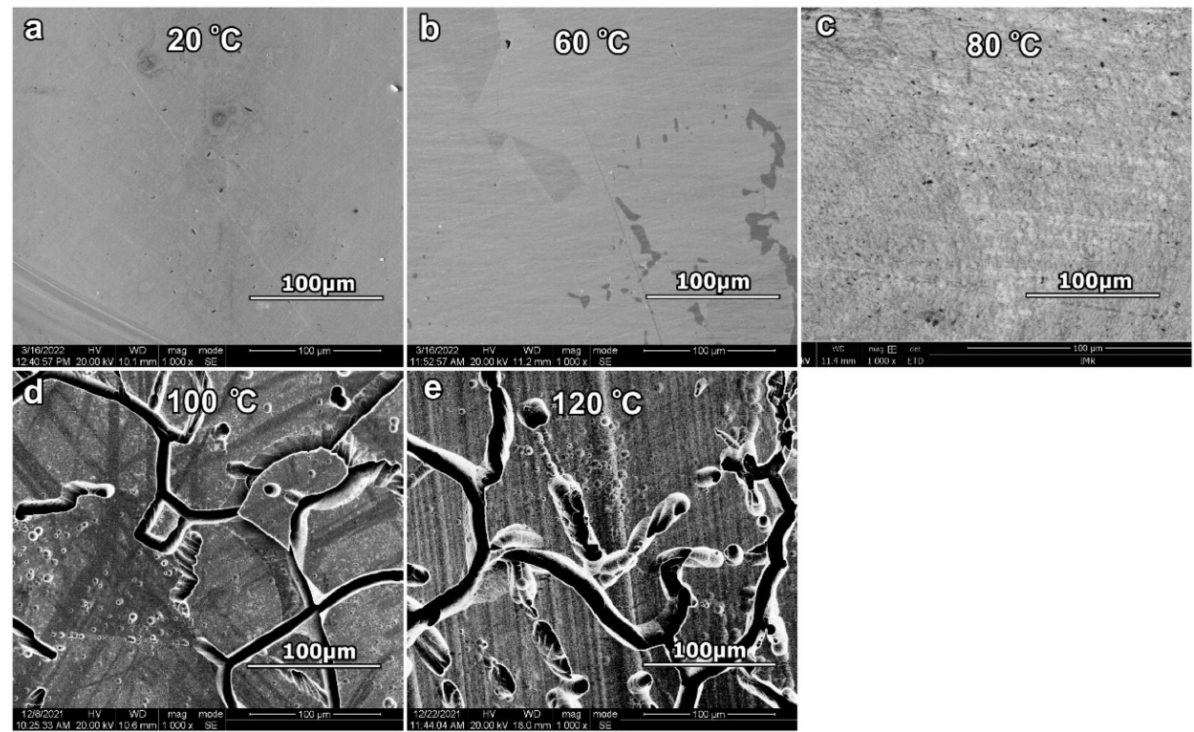
Figure 6. Corrosion morphologies of 304L stainless steel after immersion in nitric acid liquid phase at different temperatures for 120 h, ( a ) 20 ◦ C, ( b ) 60 ◦ C, ( c ) 80 ◦ C, ( d ) 100 ◦ C and ( e ) 120 ◦